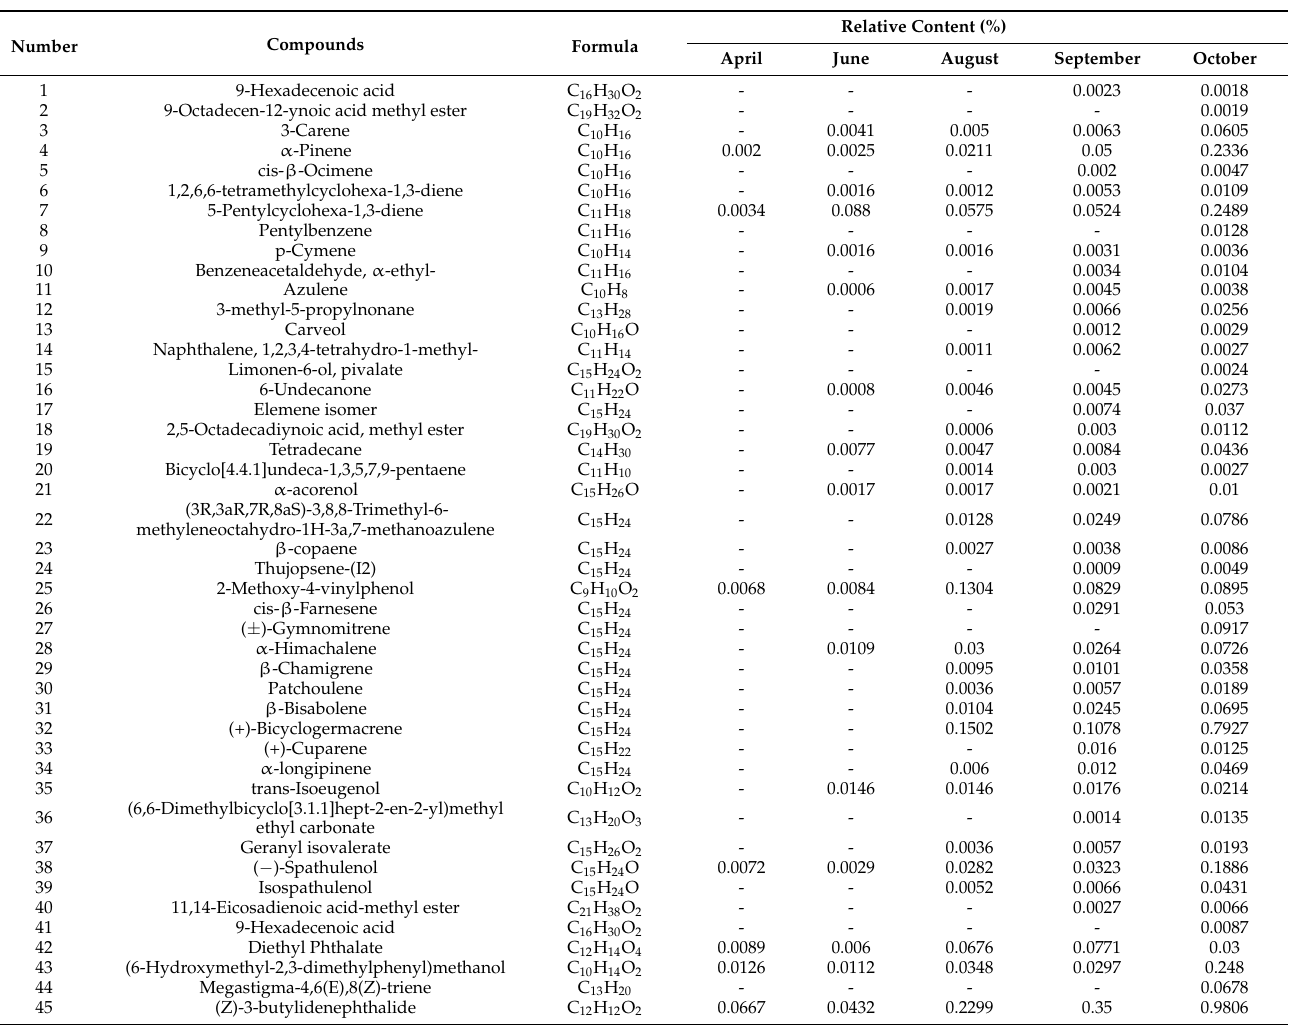
Figure 4. Total ion chromatogram from the body of A. sinensis in different periods. Note: The compounds represented by peaks 1~9 are the same as the compounds in Figure 2. Table 2. Analysis of chemical components in the body of A. sinensis in different